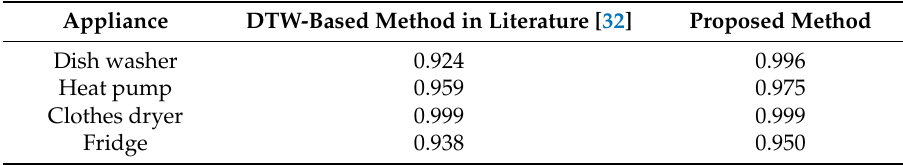
Table 7. R2 values compared with the method in literature